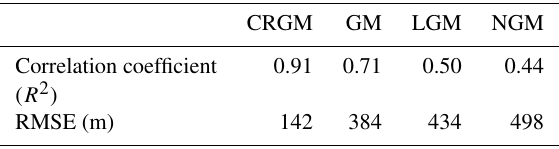
Table 1. Statistical parameters for each lidar retrieval algorithm compared with radiosonde